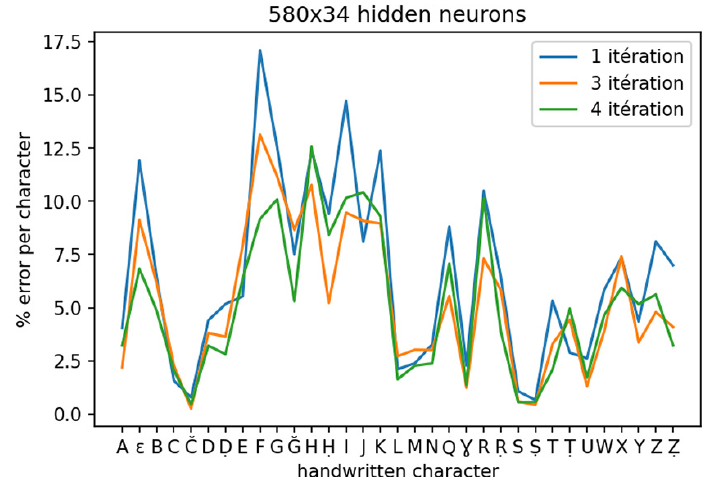
Fig. 3. The detailed results for each